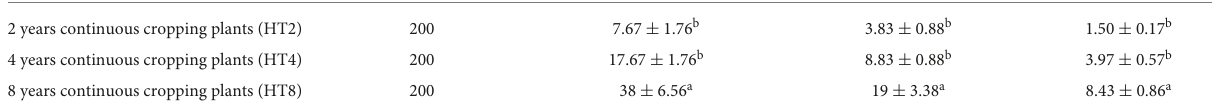
TABLE 3 Alpha diversity matrices (Mean ± SD) of each treatment group of both varieties Honghua Dajinyuan (H) and Yunyan 87 (Y). Treatments